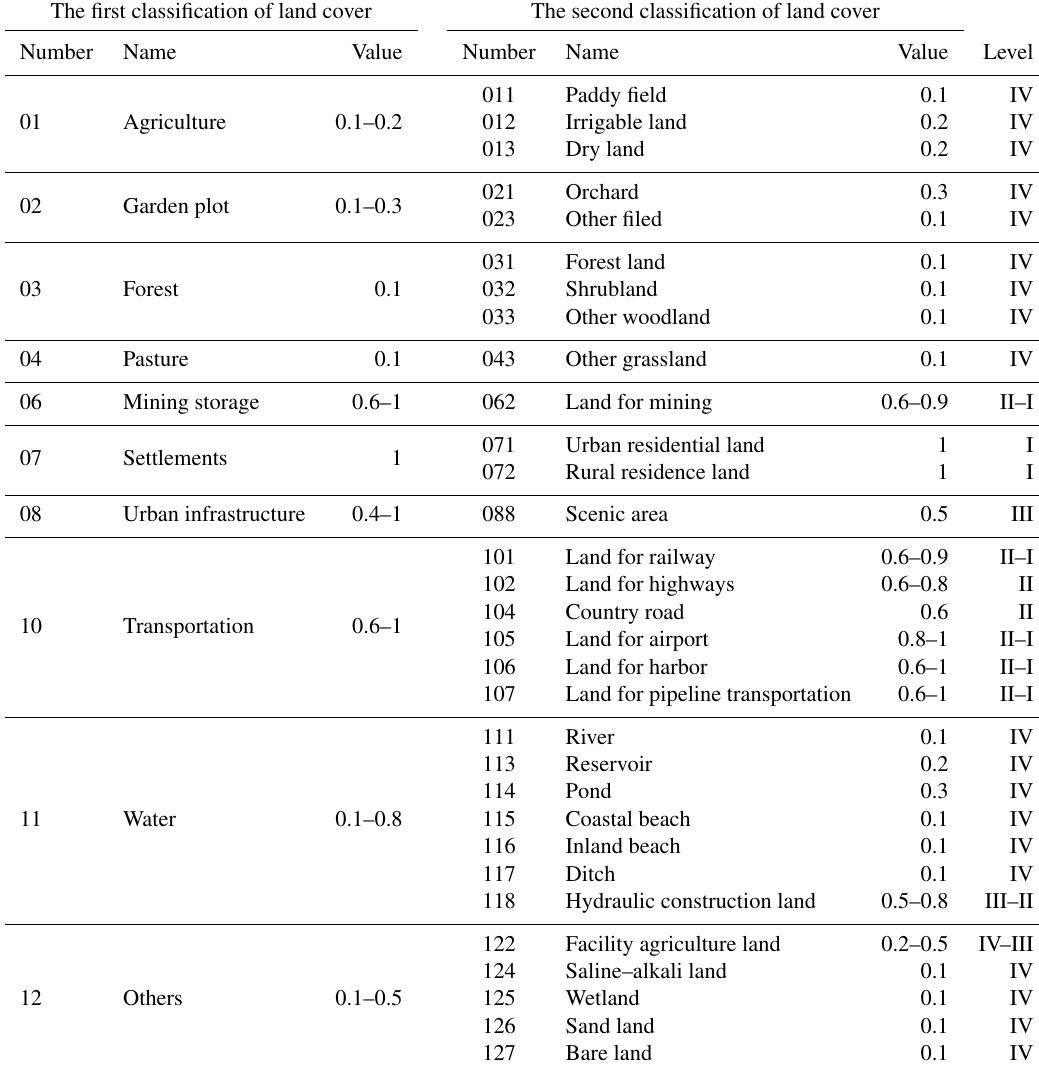
Table 7. The vulnerability value and vulnerability level for different land cover types. The first classification of land cover